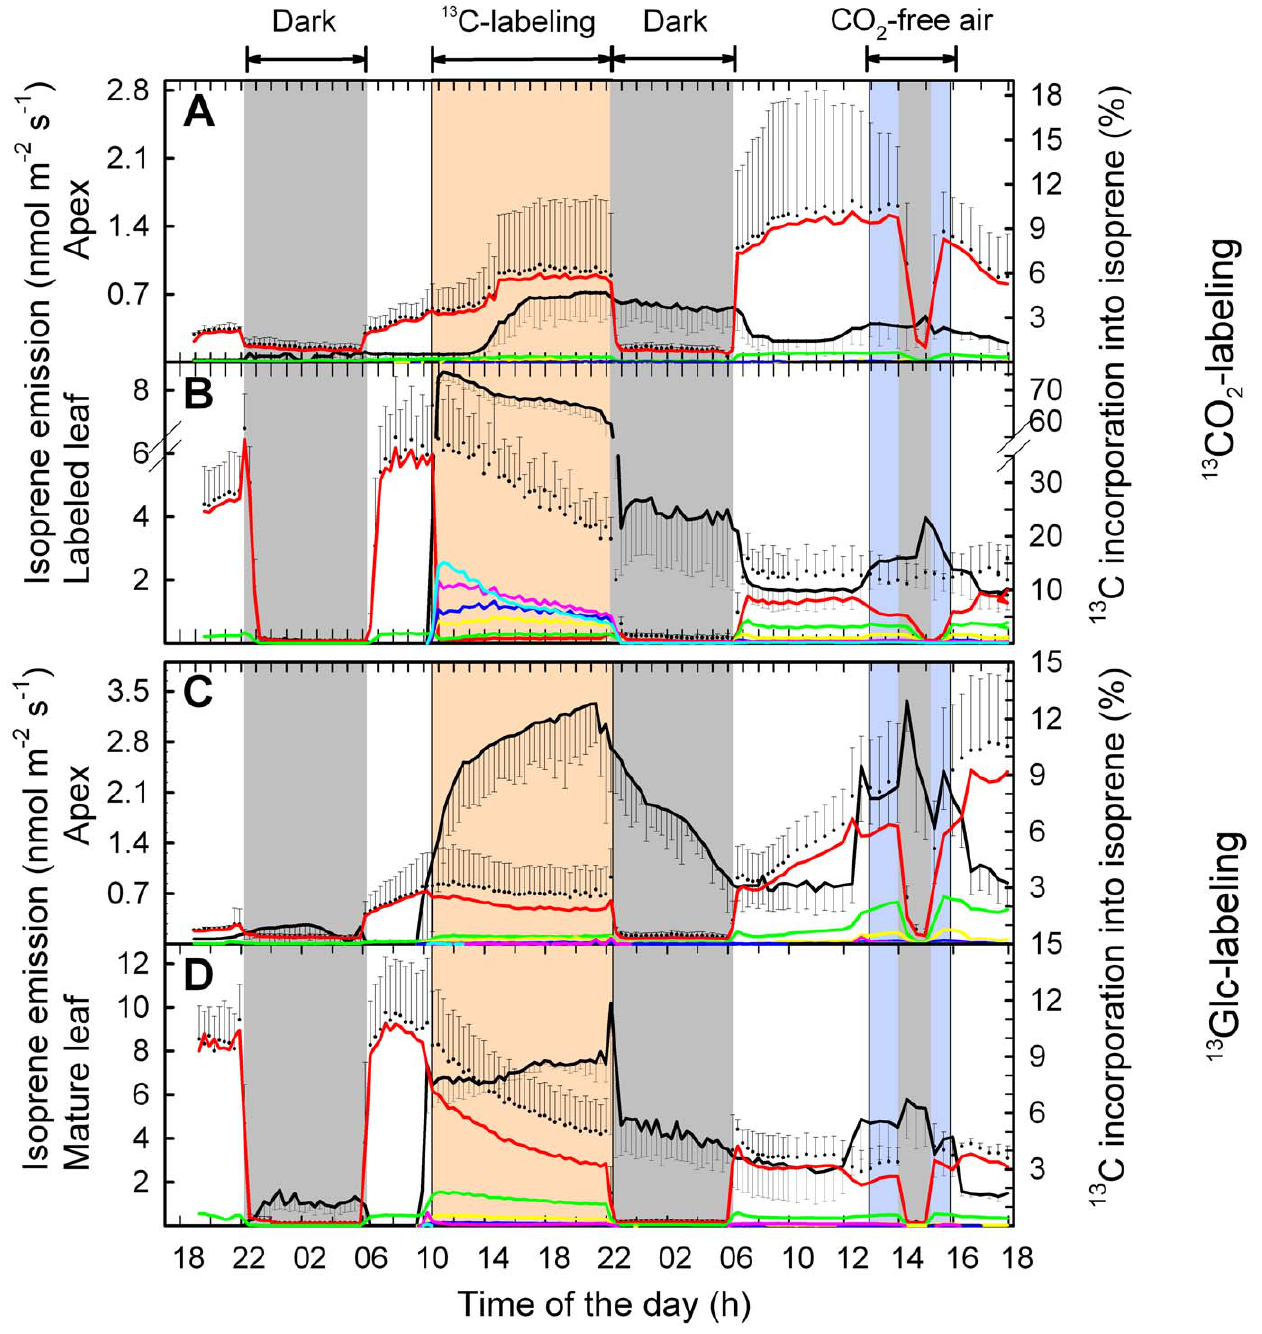
Figure 7. Isoprene emission of detached poplar shoots and 13 C incorporation upon 13 CO 2 and 13 C-glucose feeding. Total isoprene emission (black symbols), its 13 C incorporation (black line) and isotopic composition (m74, light blue; m73, magenta; m72, dark blue; m71, yellow; m70, green; m69, red) in (A, C) apical buds and (B, D) mature leaves from shoots labeled with (A, B) 13 CO 2 or (C, D) 13 Glc. The labeling period is shown in orange, stress (absence of CO 2 ) is indicated by a blue background, and dark conditions are marked in grey. Details of the experimental phases can be found in the Materials and Methods section. Data represent the mean of three experiments 6 s.e. (omitted for isotopic composition).